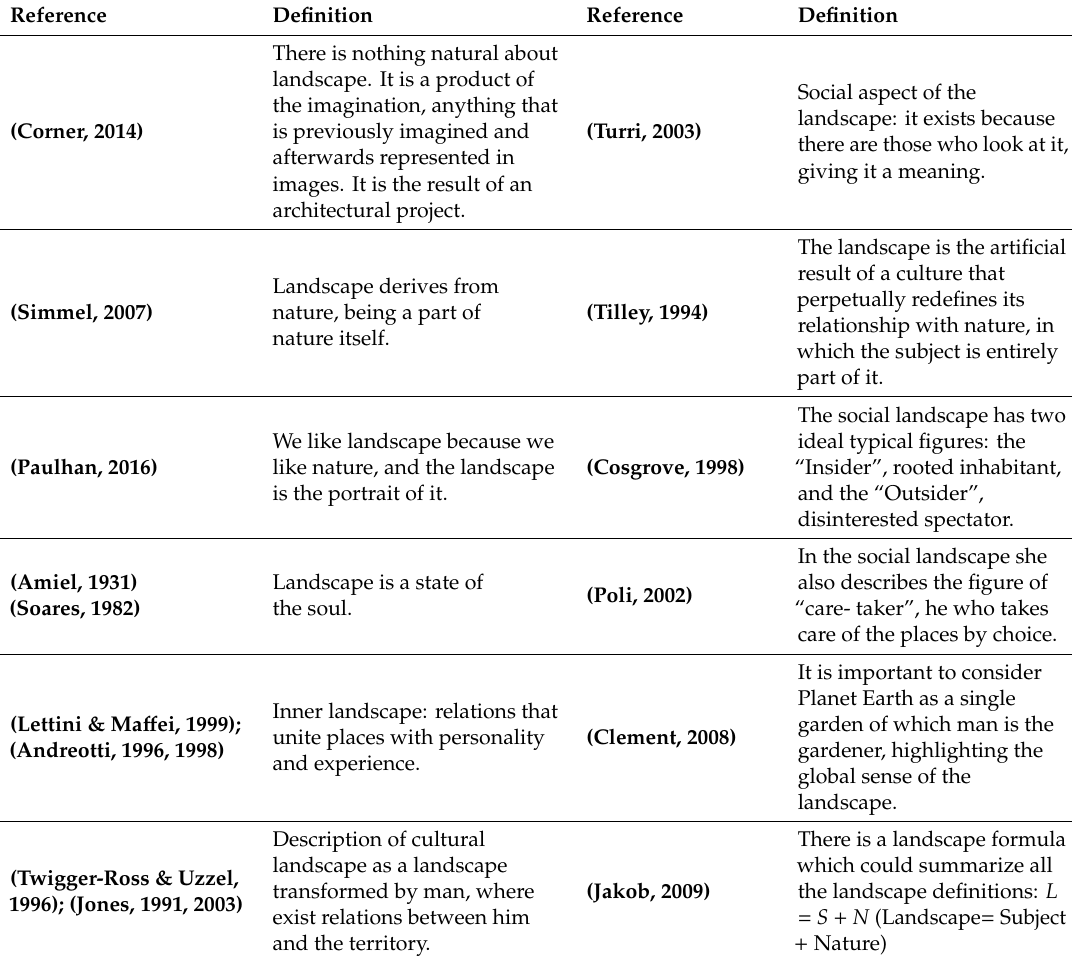
Table 1. Summary of some existing theories about landscape, used in the